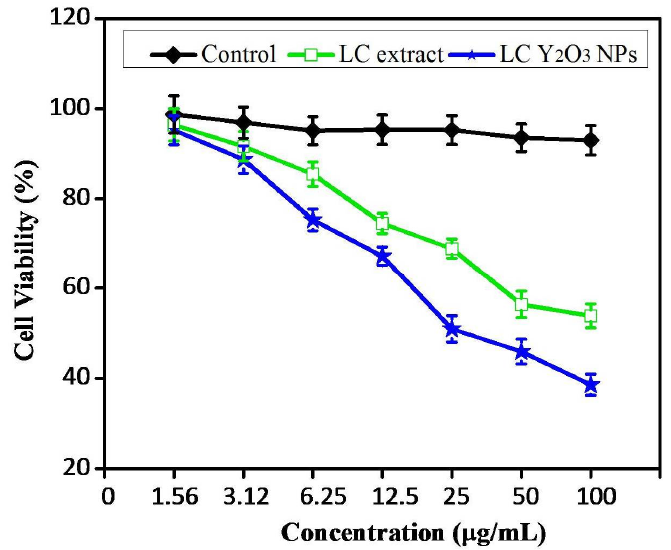
Figure 6. Green LC Y 2 O 3 NPs inhibit the cell viability of human cervical carcinoma HeLa cells. HeLa cells were treated for 24 h with various concentrations of LC extract and green LC Y 2 O 3 NPs.